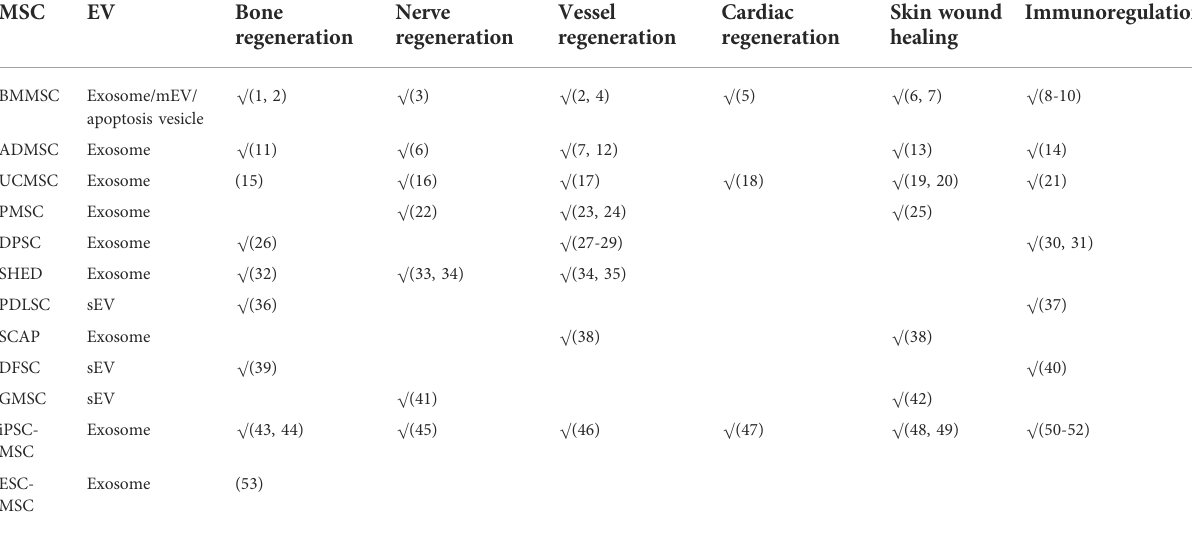
TABLE 1 Different regenerative effects of MSC-EVs from distinct